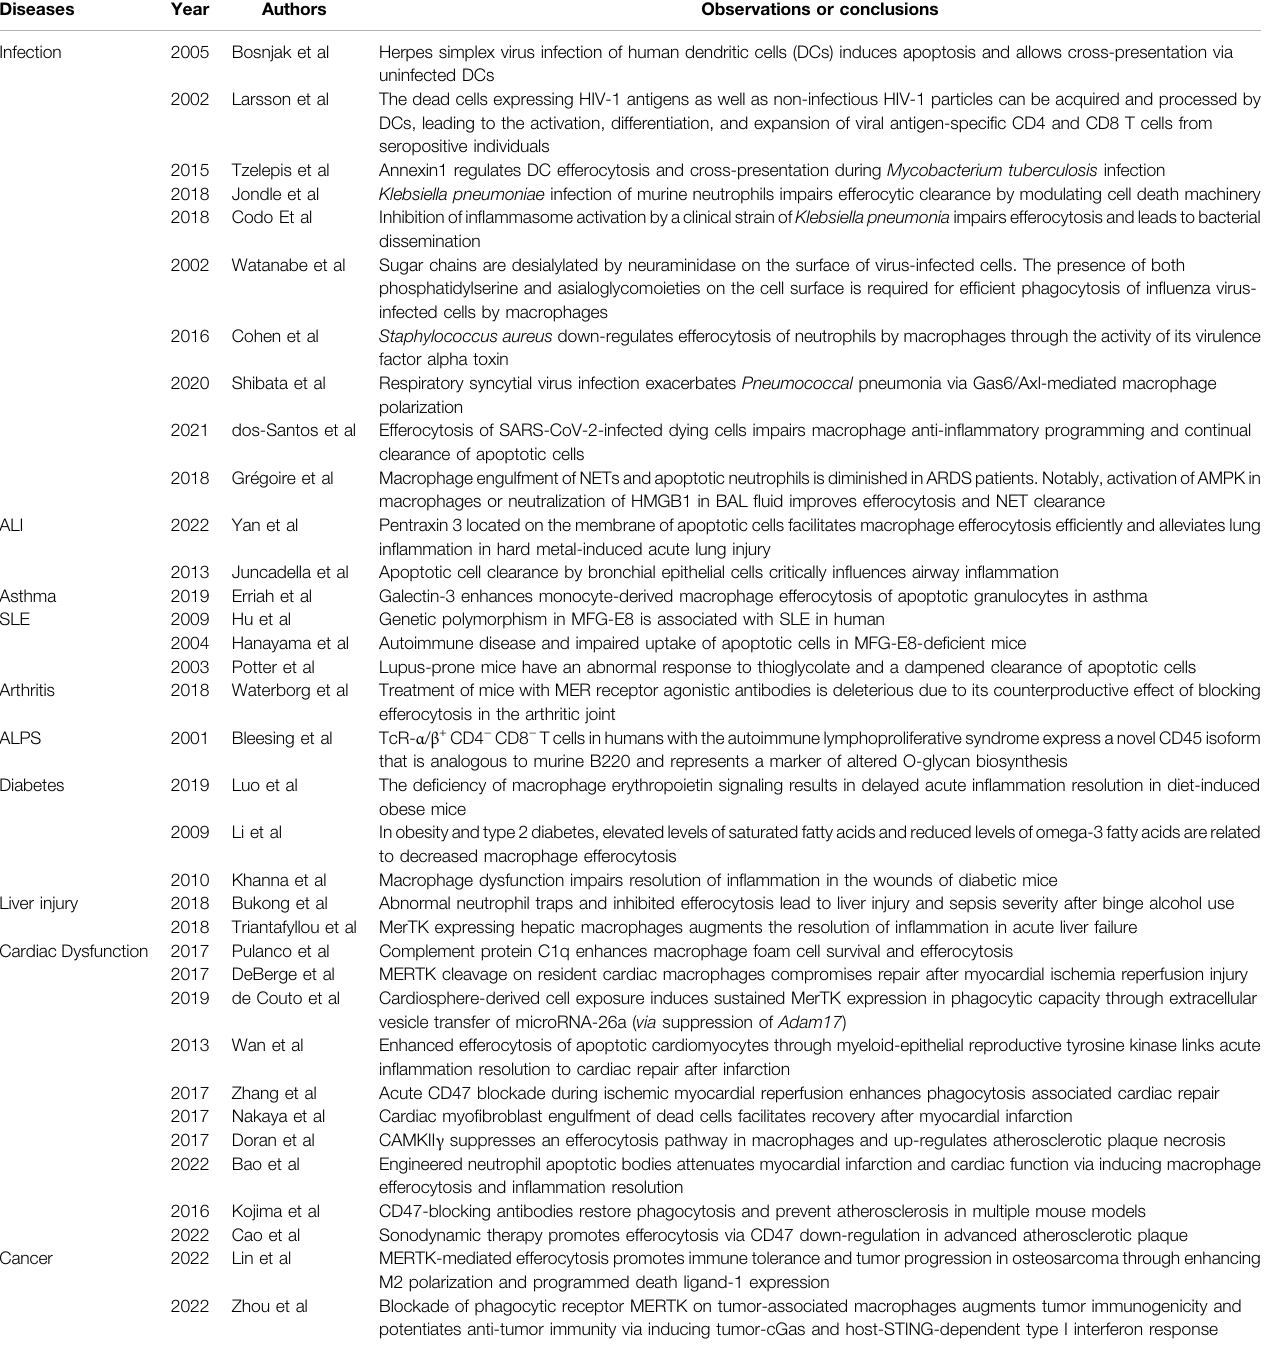
Abbreviations:Dendritic cells,DCs; Gas6, growtharrestspeci fi c 6; RA,rheumatoidarthritis;SLE, systemiclupuserythema; ALI,acutelunginjury;MFG-E8,milkfat globule-EGFfactor 8; ARDS, acute respiratory distress syndrome; ALPS, autoimmune lymphoproliferative syndrome; MERTK, MER proto-oncogene tyrosine kinase; CaMKII γ , Ca2+/calmodulin-dependent protein kinase γ ; NETs, neutrophil extracellular traps; AMPK, AMP-activated protein kinase; HMGB1, high mobility group box-1 protein; BAL, bronchoalveolar lavage; SARS-CoV-2, severe acute respiratory syndrome coronavirus 2.